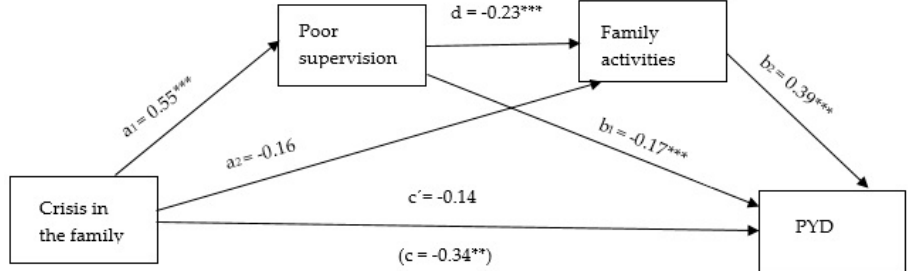
Figure 1. Serial mediation by poor supervision and few family activities of the relation between crisis in the family and PYD. Notes: * p < 0.05, ** p < 0.01, *** p < 0.001. All presented effects are unstandardized; a n is the effect of crisis in the family on mediators; b n is the effect of mediators on PYD; c’ is the direct effect of crisis in the family on PYD, and c is the total effect of crisis in the family on PYD; d is the effect of poor supervision on family activities.